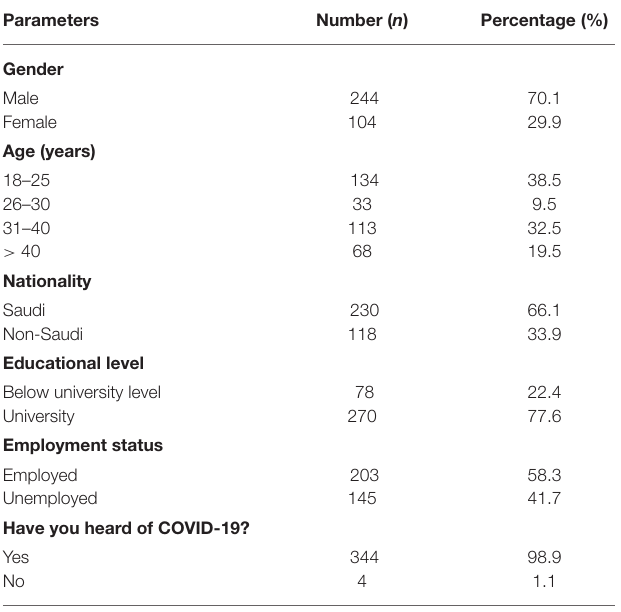
TABLE 1 | Participant ( n = 348) demographics and professional